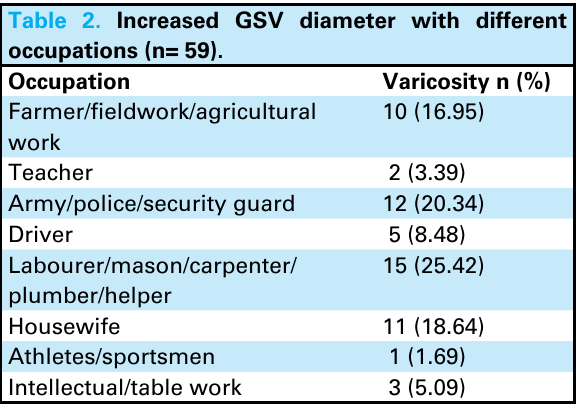
Table 2. Increased GSV diameter with different occupations (n= 59).